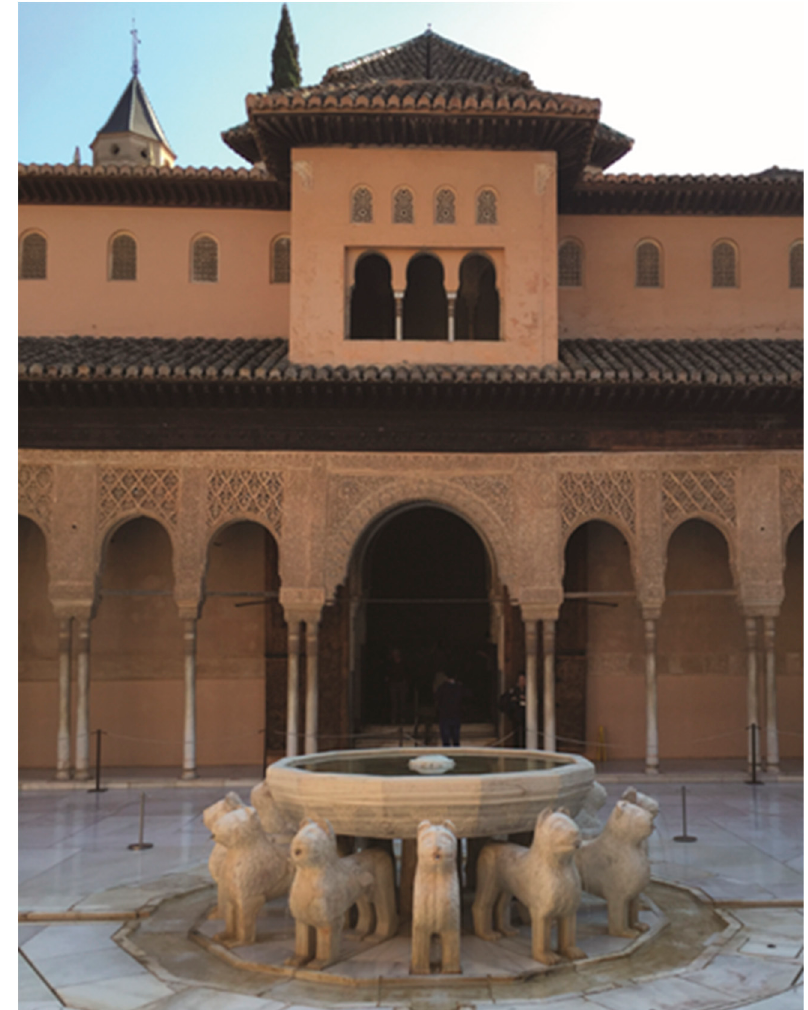
Figure A1. Hayden [125] highlights technological aggrandizement as example of art emerging among human communities that have achieved stable surpluses of food and other resources. One example is found at the Alhambra palace in Granada, Spain. In addition to intensive ornamentation throughout the palace, the Court of the Lions built in the 14th century by the Nasrid Sultan focuses on an alabaster fountain perched on 12 marble lions which originally contained a complex mechanism to allow a different lion to pour water each hour. (Photo: S.L.Katz).